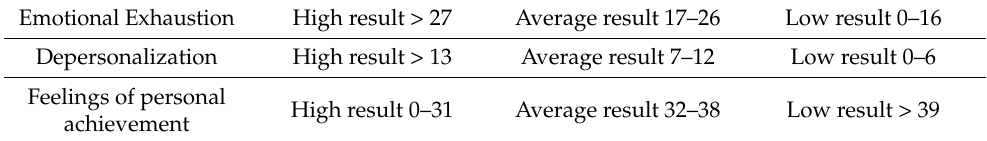
Table 2. Ranges of results of the MBI.